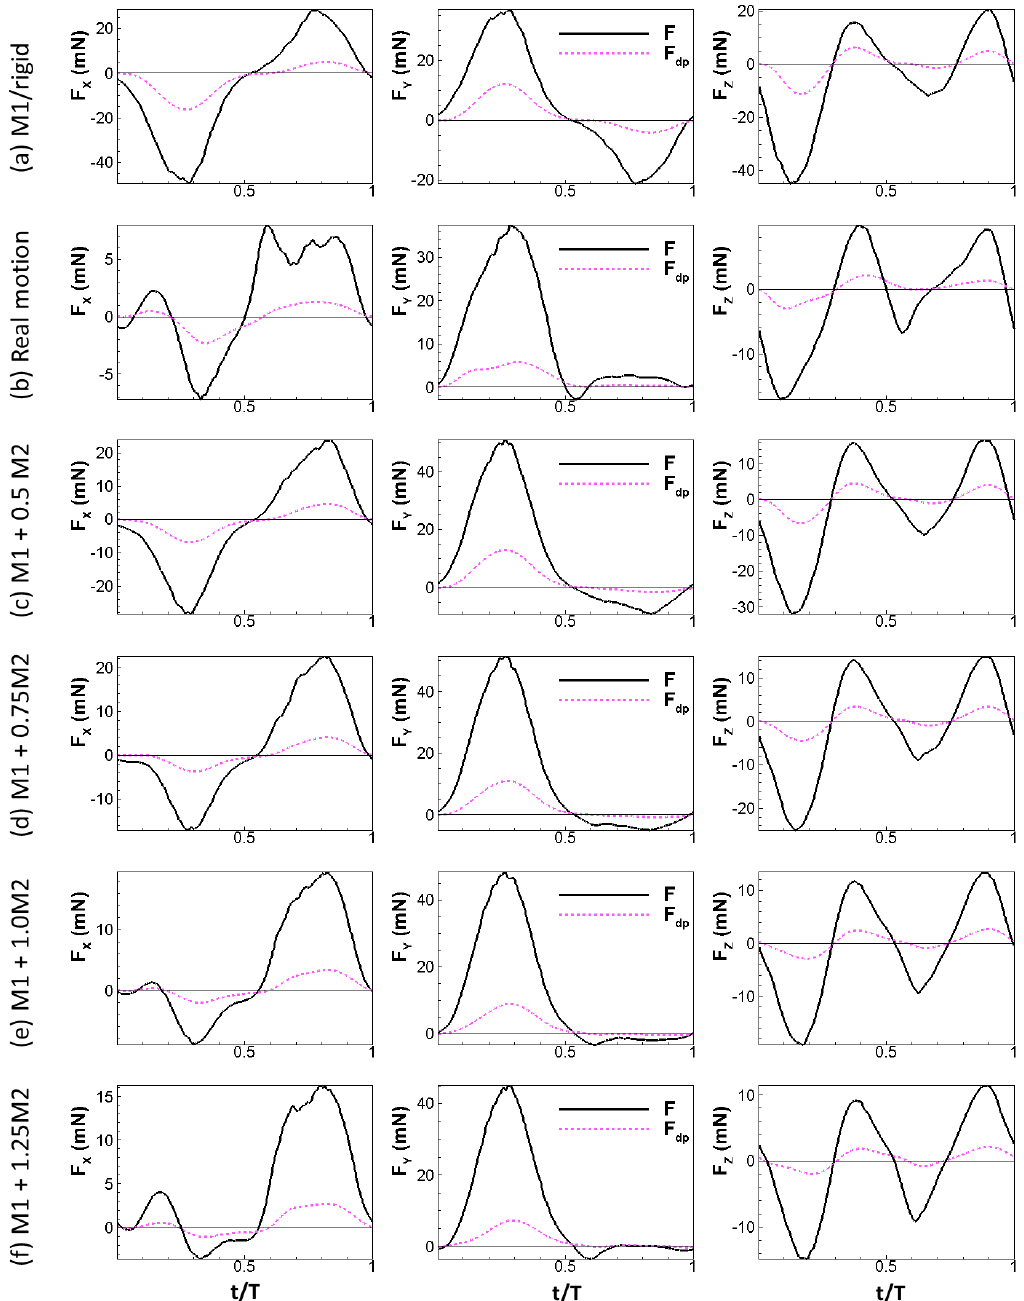
Figure 6. Aerodynamic forces of the wing compared to dynamic pressure force for all the tested models under V 0 = 2.67